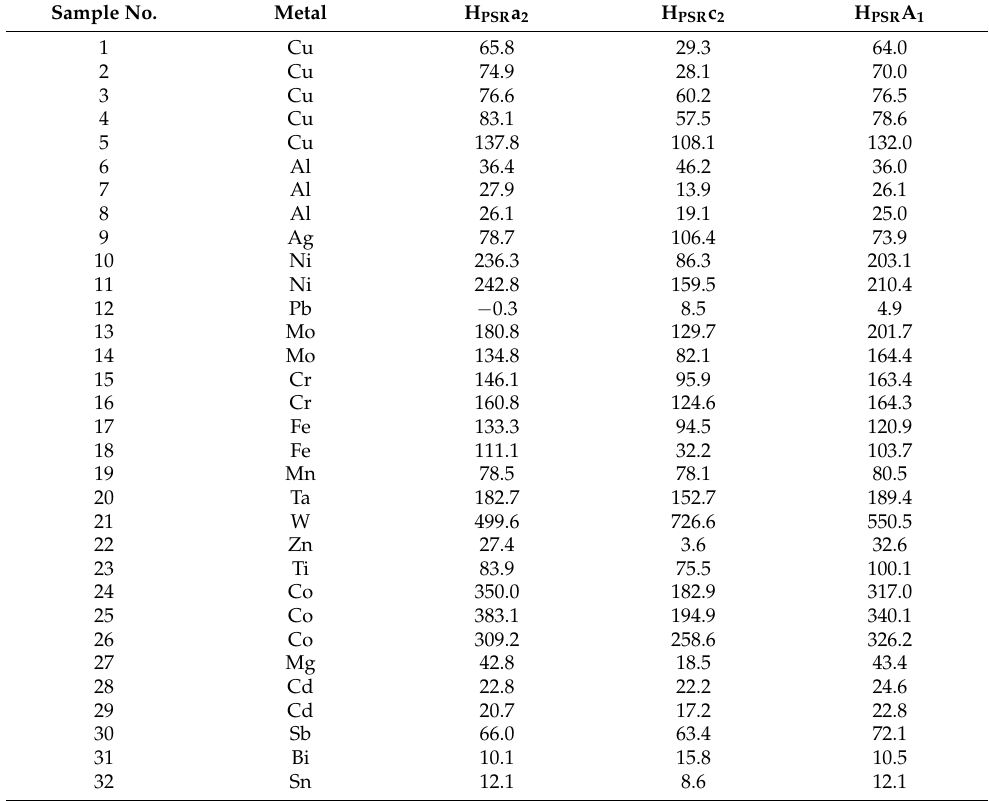
Figure 4. The relationship between measured hardness HV0.05 and calculated values of “true hardness” (H PSR ) relationship between Meyer’s index n and W, the minimum test load W (N) necessary to initiate plastic deformation. Table 5. The vales of “true hardness”. Sample No.